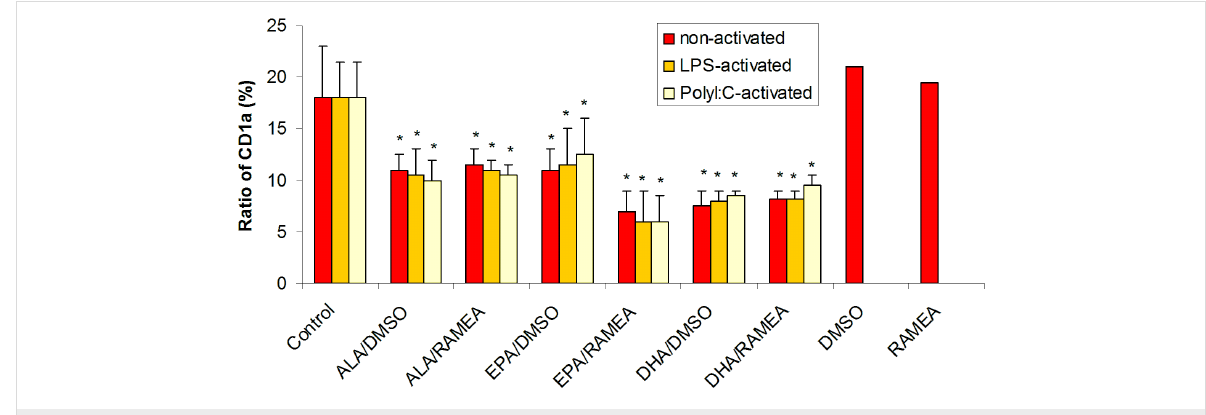
Figure 4: The effect of n − 3 PUFAs on the expression of CD1a cell surface protein in resting (red), LPS-activated (yellow) and Poly(I:C)-activated (white) moDC ( N = 6) (* p < 0.05 compared to the control).